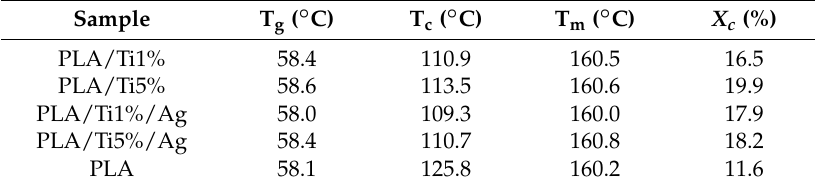
Table 3. Thermal Characteristics of pure PLA and PLA nano-blend